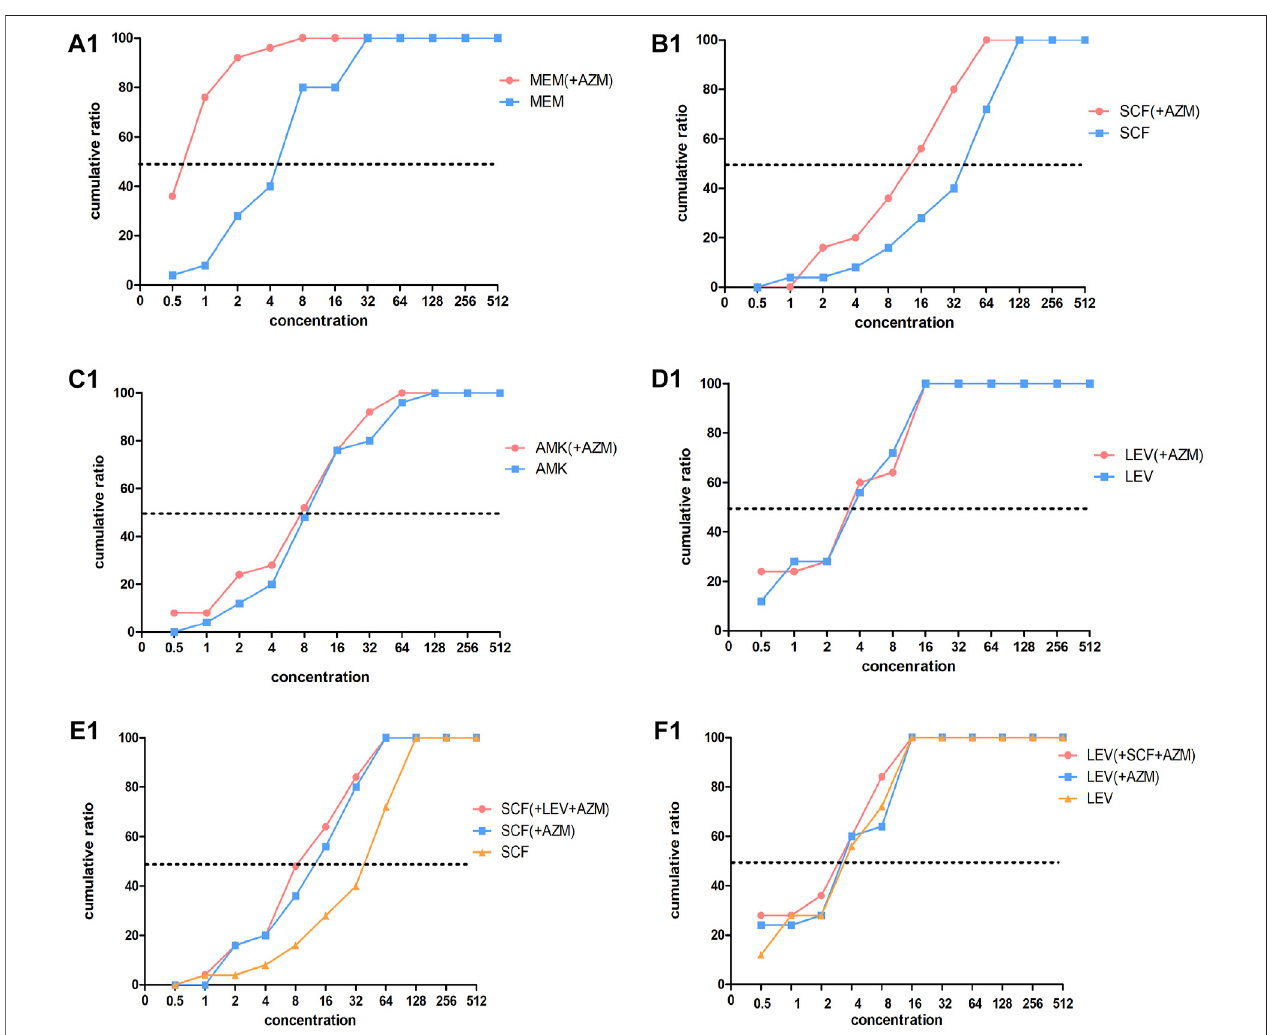
FIGURE 2 | Concentration cumulative bacteriostatic percentage curves of four antibiotics. Abbreviations: MEM, meropenem; SCF, cefoperazone/sulbactam; AMK, amikacin; LEV, levo fl oxacin; AZM: azithromycin.